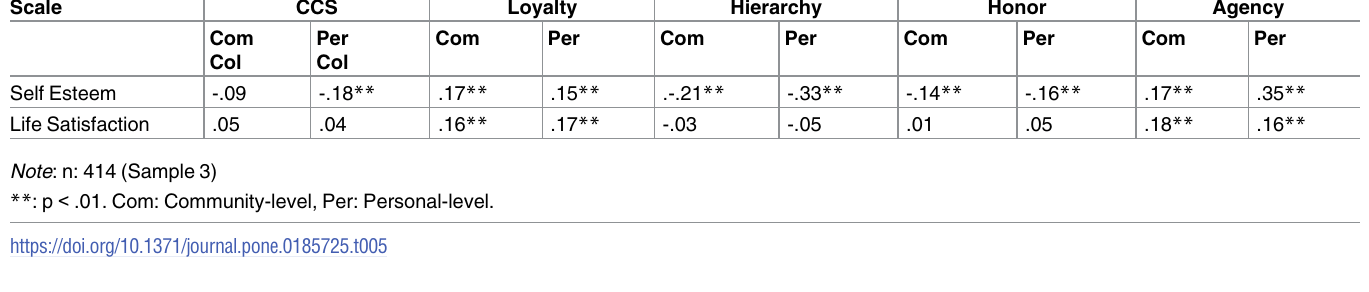
Table 5. Correlations between Community Collectivism subscales and Self-Esteem, and Life-Satisfaction measures. Scale CCS Loyalty Hierarchy Honor Agency Com Per Com Per Com Per Com Per Com Per Col Col Self Esteem -.09 Life Satisfaction